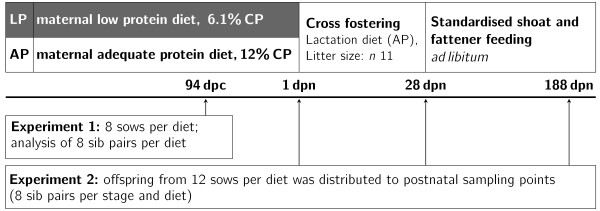
Experimental design.